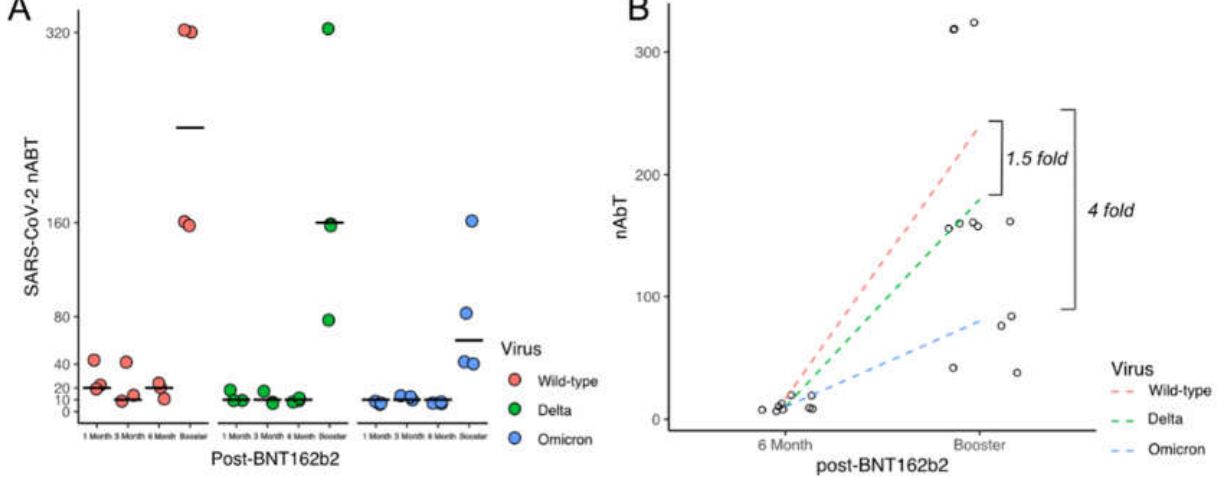
Figure 1. Increases in neutralising antibody titres (nAbT) four weeks after the third dose of Pfizer- BioNTech (BNT162b2). ( A ) Illustrates the neutralising antibody titre (nAbT) of SARS-CoV-2 variants Delta (green) and Omicron (blue) compared to wild-type (red, SARS-CoV-2 lineage A.2.2); black lines indicate the median titre at each time point. ( B ) Sera from four individuals collected six months after two doses of Pfizer-BioNTech (BNT162b2) and four weeks after the third dose of BNT162b2 vaccine (booster dose) demonstrate an increase in nAbT against all three variants. However, a 1.5- and 4-fold reduction in nAbT is observed for Delta and Omicron, respectively, compared to wild-type. Dashed lines depict the linear regression between individual titres (circles) pre- and post-BNT162b2 booster for each